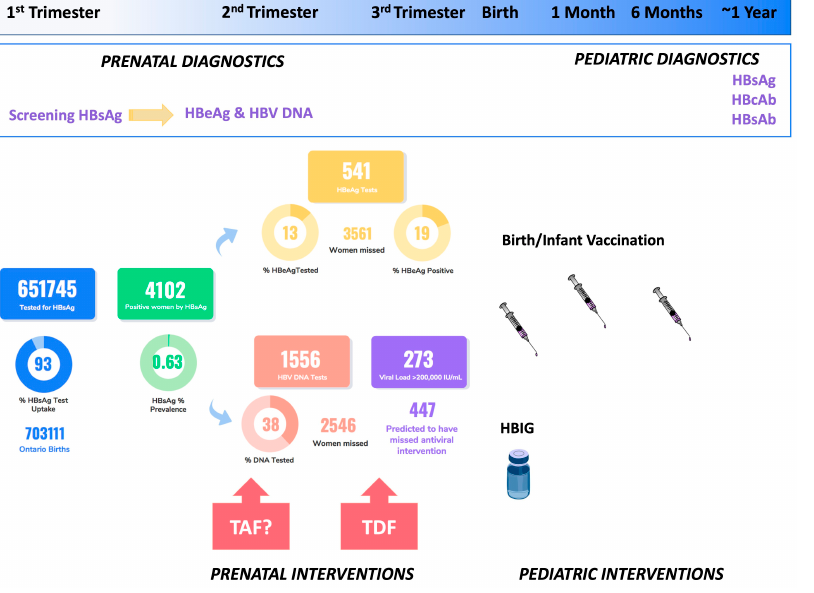
Figure 1. HBV prenatal screening uptake, prevalence, and missed opportunities for interventions from 2012–2016 (reproduced from [37] with modifications), and interventions to prevent transmis- sion.